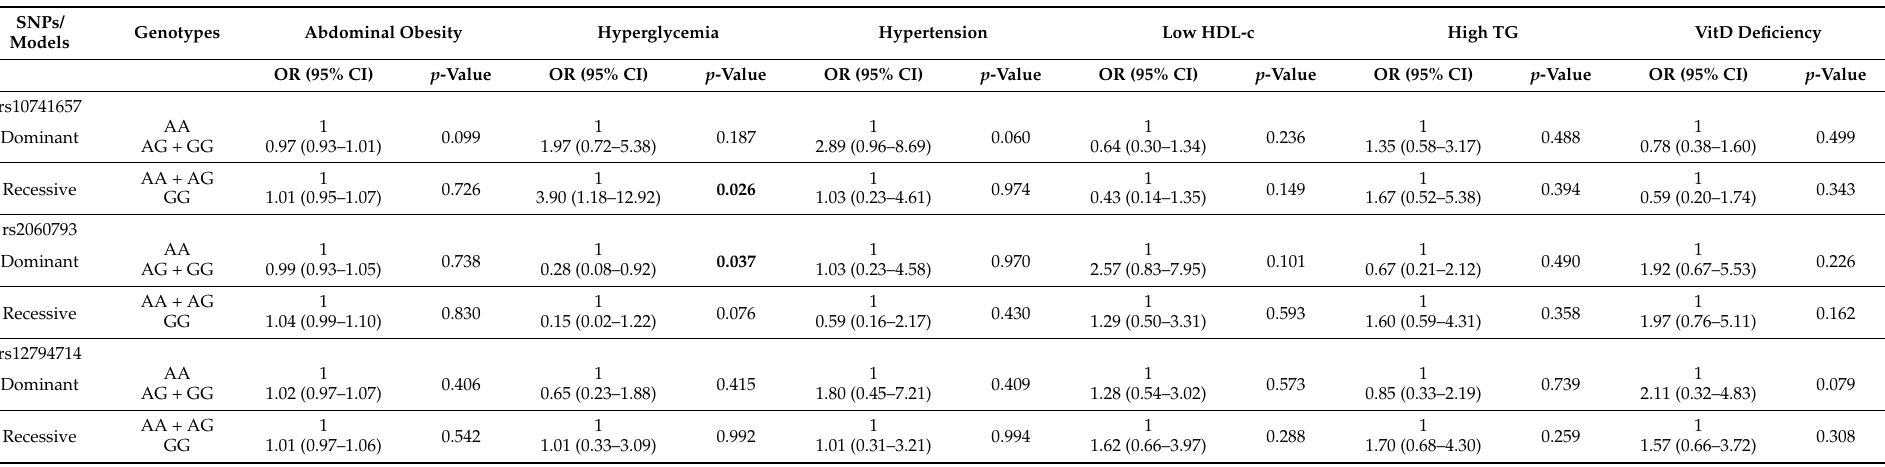
Table 4. Association of CYP2R1 polymorphisms with components of MS and vitamin D